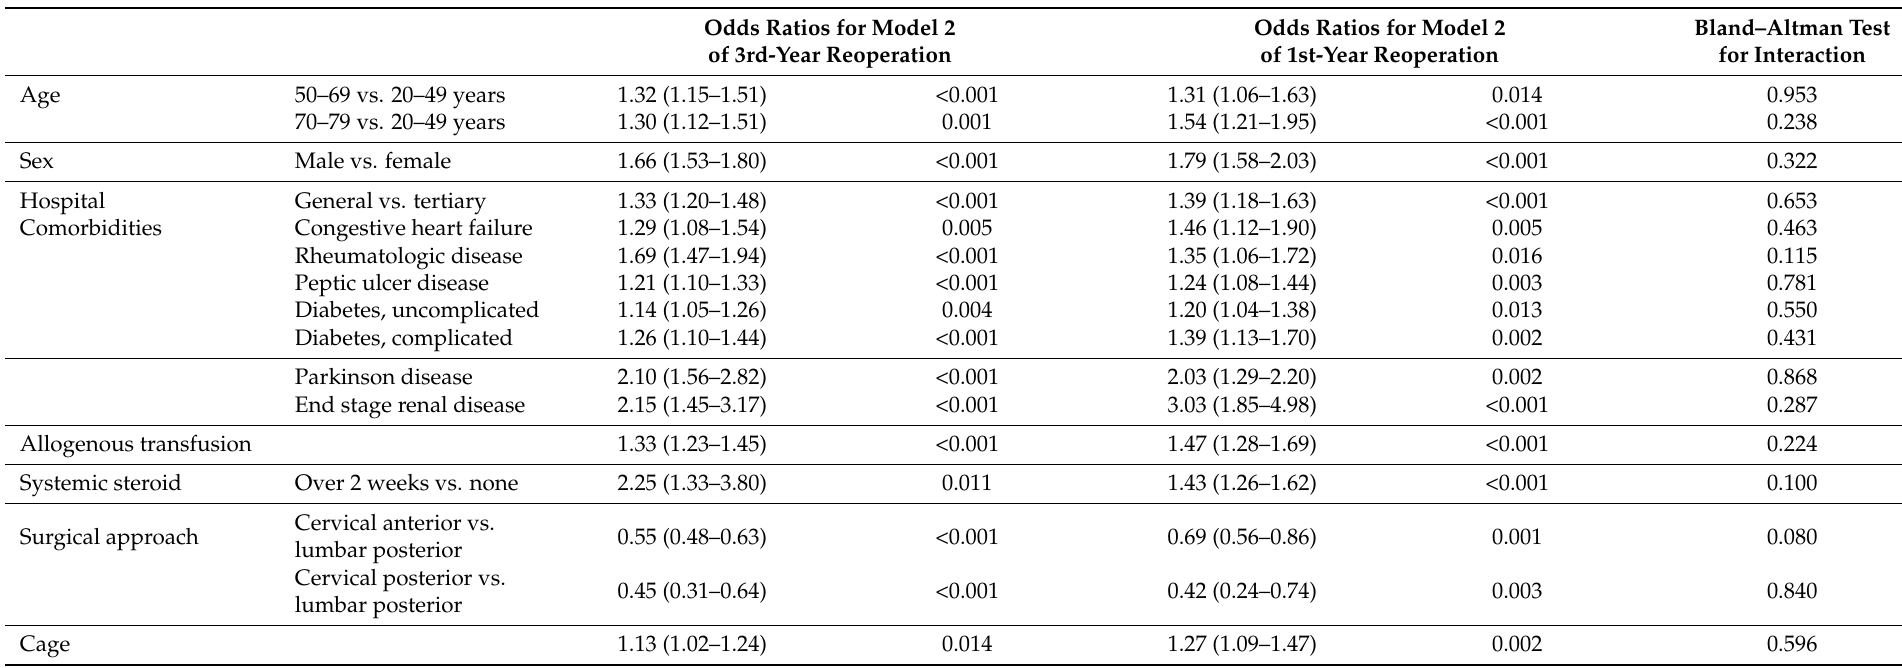
Table 6. Comparisons of the adjusted odds ratios of the consistent variables in the two prediction models (1st-year vs. 3rd-year